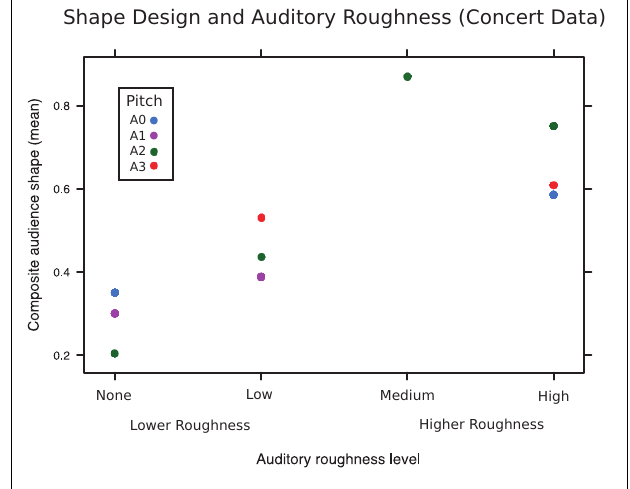
FIGURE 3 | Collaborative audience shape-design in Experiment 1 (Live Concert setting), for each block of noise, showing different levels of roughness, and